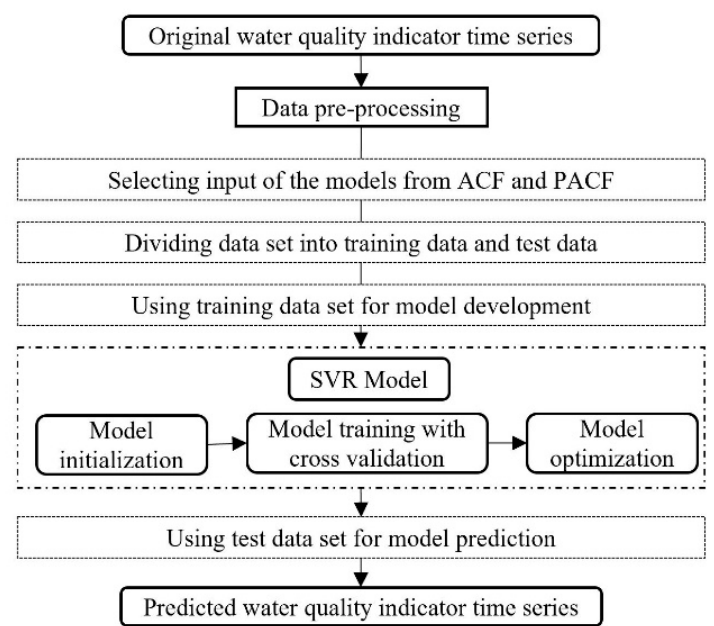
Figure A1. Flow chart of the standalone SVR structure for the prediction of water quality indicators.